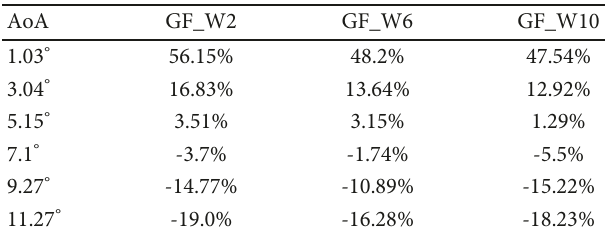
Table 1: E ff ect of GF widths on the lift-to-drag ratio for the S809